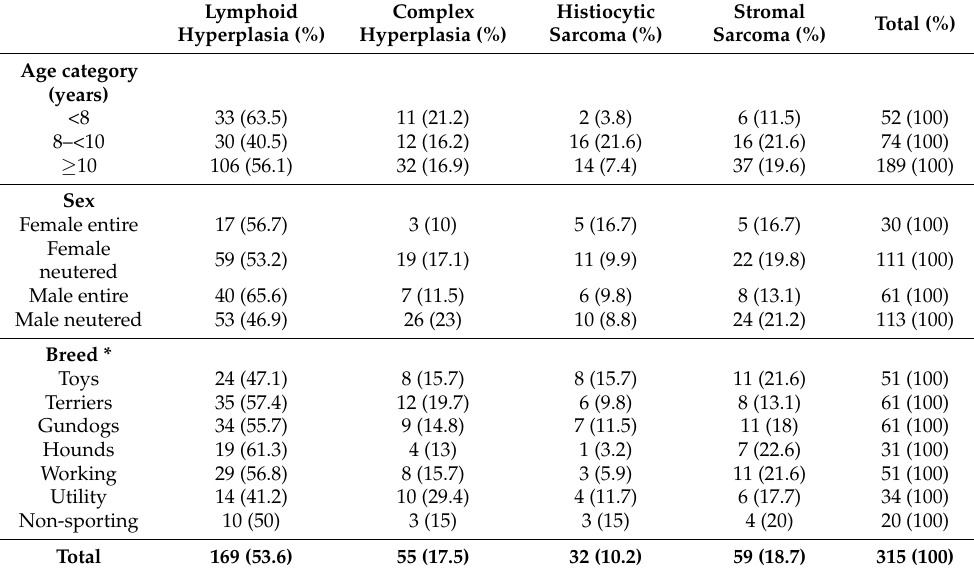
Table 3. Distribution of patients diagnosed with splenic lymphoid hyperplasia, complex hyperplasia, histiocytic sarcoma, and stromal sarcoma by age, sex, and breed among splenectomized dogs with a definitive histopathological diagnosis of the four splenic nodules identified from the VetCompass Australia database covering 96 primary-care veterinary clinics between 1989 and